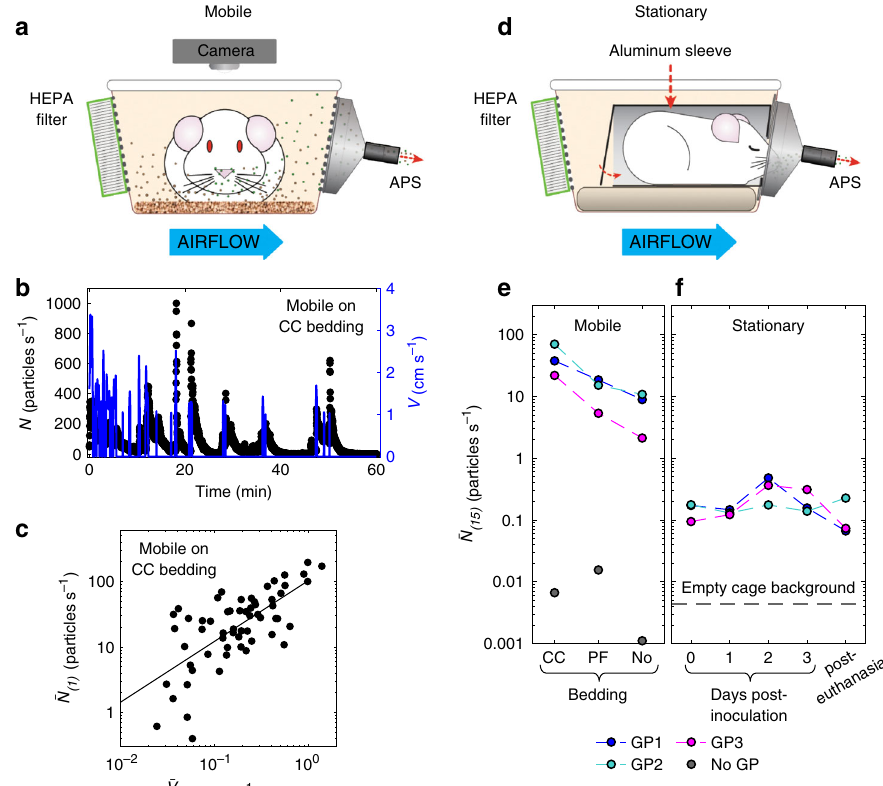
Fig. 1 Guinea pigs aerosolize more dust than respiratory particles. a Schematic for aerodynamic particle sizer (APS) experiments to quantify the airborne particulates generated by awake, unrestrained (mobile) guinea pigs (GP) (Supplementary Fig. 1). b Representative instantaneous particle emission rate (left axis) and instantaneous guinea pig movement velocity (right axis) vs. time for a mobile guinea pig in a cage with granular dried corncob (CC) bedding. c Time-averaged particle emission rate over 1 min ð (cid:1) N ð 1 Þ Þ vs. time-averaged guinea pig movement velocity over 1 min ð (cid:1) V ð 1 Þ Þ . Solid line is the power law fi t with exponent 0.93, correlation coef fi cient 0.80, and p -value 9.6 × 10 − 15 . d Schematic for APS experiments to measure the particulates produced by anesthetized or euthanized (stationary) guinea pigs (Supplementary Fig. 4). e Particle emission rates, time-averaged over 15 min ð (cid:1) N ð 15 Þ Þ , for three mobile guinea pigs (GP1, GP2, and GP3). Gray markers denote background particle counts without a guinea pig in the cage with different beddings (dried corncob granulas (CC), polar fl eece-covered absorbent pads (PF), or no bedding (No) on the plastic cage fl oor). f Measurements of the particle emission rates, time-averaged over 15 min ð (cid:1) N ð 15 Þ Þ , for stationary guinea pigs, performed prior to inoculation (day 0) and on days 1, 2, and 3 post-inoculation with in fl uenza A/Panama/2007/1999 (H3N2) (Pan99) virus, and after euthanasia. Horizontal gray dashed line denotes background particle counts of empty cage. Particle emission rates are the total of all particles detected in the size range of 0.3 – 20 μ m in diameter (Supplementary Figs. 2 and 3). Source data are provided as a Source Data fi